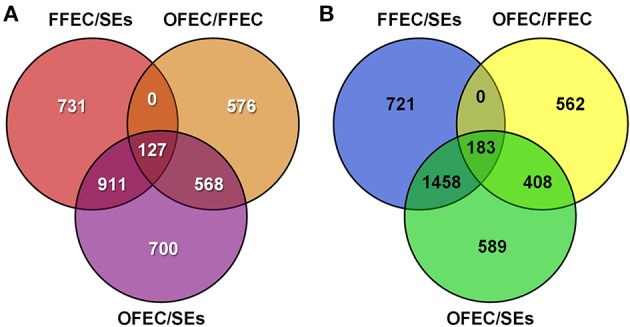
The Venn diagram depicts the (A) upregulated and (B) downregulated genes in paired comparisons. FFEC/SEs, fresh friable embryogenic callus/somatic embryos; OFEC/FFEC, old friable embryogenic callus/fresh friable embryogenic callus; OFEC/SEs, old friable embryogenic callus/somatic embryos.